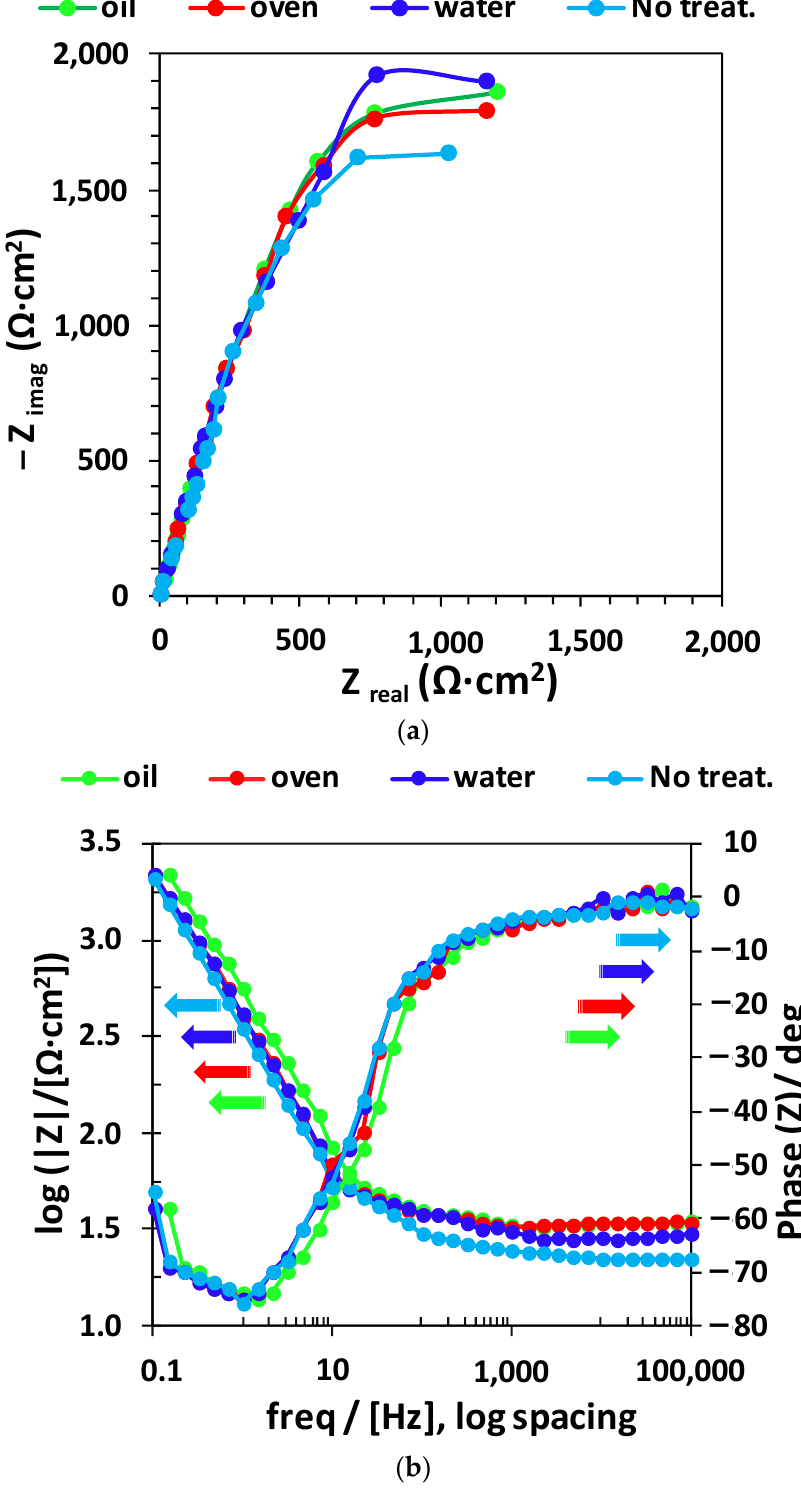
Figure 10. Nyquist ( a ) and Bode ( b ) diagrams of Ti-6Al-7Nb at 25 °C in artificial saliva and E corr . The drift from the perfect semicircle was usually ascribed to frequency dispersion, as well as to the surface inhomogeneities and resistive mass transport [23]. From the diagrams, it is obvious that the impedance response of the untreated samples displayed a noticeable difference from that of the tempered specimens. The complete Nyquist impedance loop intersects the real axis at both higher and lower frequencies. At the high frequency point, the intersection matches the solution resistance (R sol ), and at the low frequency point, it matches the sum of R sol and the load transfer resistance (R ct ). The difference of both values gives R ct . The R ct value is a function of the electron transfer through the immersed area of the alloy and is inversely dependent with the corrosion rate [24]. The impedance response can be properly represented by using electrical circuits that